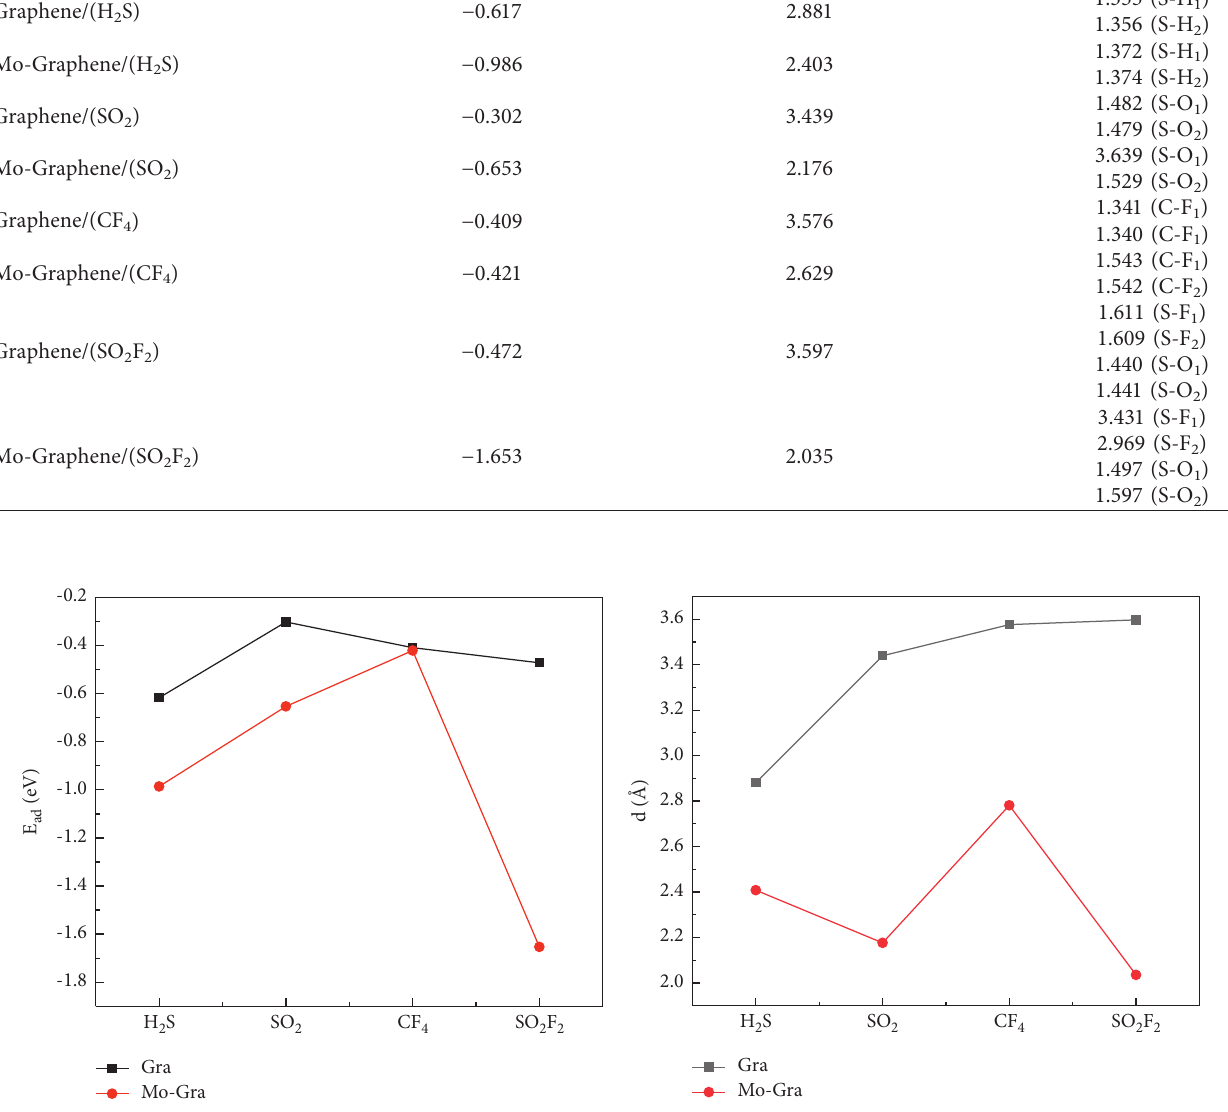
2 S, SO 2 , CF 4 , and SO 2 F 2 in different graphene structures: (a) adsorption energies and (b) adsorption